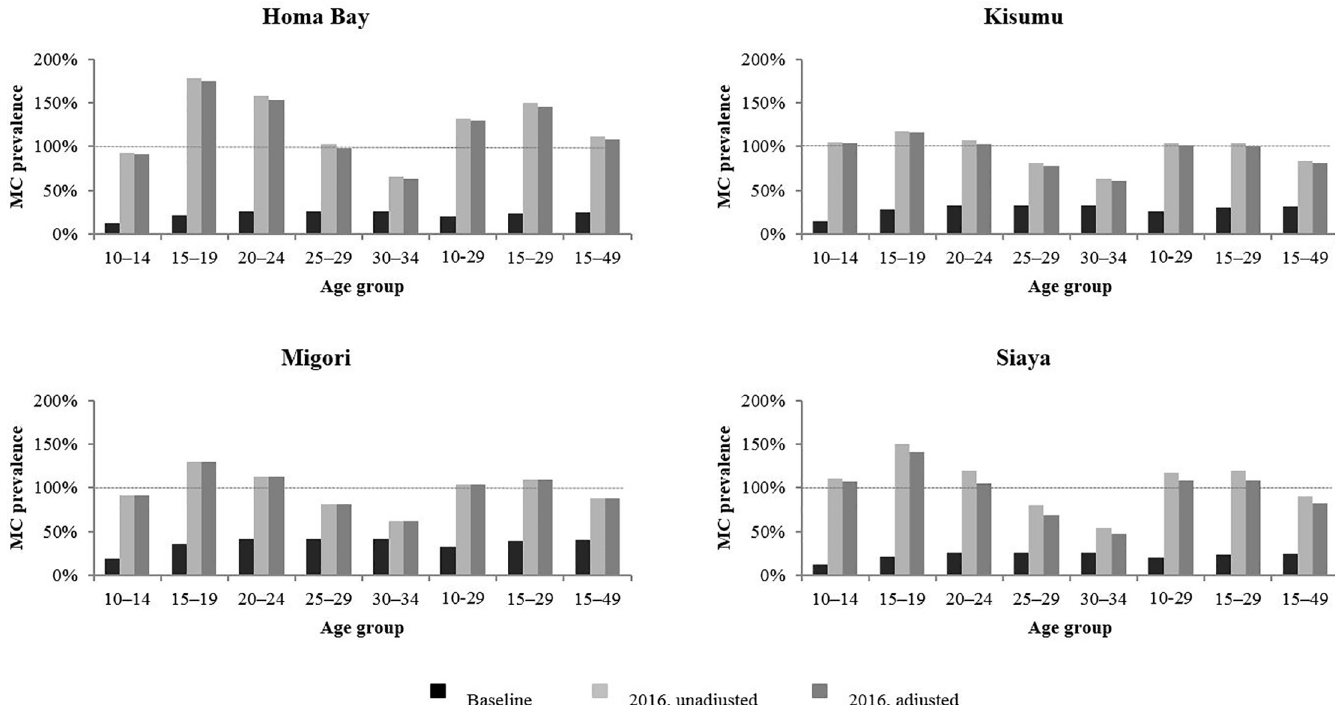
Fig 2. Male circumcision (MC) prevalence before start of voluntary medical male circumcision (VMMC) program, unadjusted modeled MC prevalence by end 2016, and adjusted modeled MC prevalence by end 2016 correcting for duplicate reporting for Homa Bay, Kisumu, Migori, and Siaya. Black bars represent age specific MC prevalence before the start of the VMMC program. Light grey bars represent unadjusted modeled age specific MC prevalence by end 2016. Dark grey bars represent adjusted modeled age specific MC prevalence by end 2016 correcting for duplicate reporting. Dashed horizontal line denotes MC prevalence of 100%.